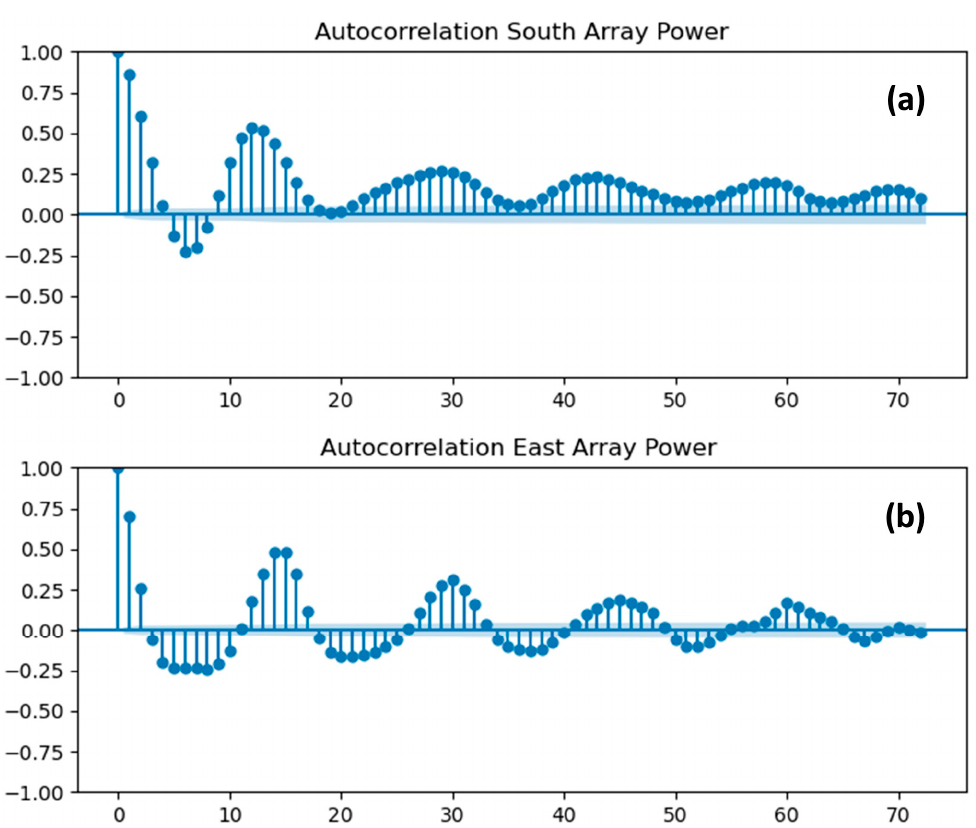
5 of 12 Figure 2. BIPV power datasets for south and east arrays. Table 1. Case matrix for exploring the role of exogenous variables. Case